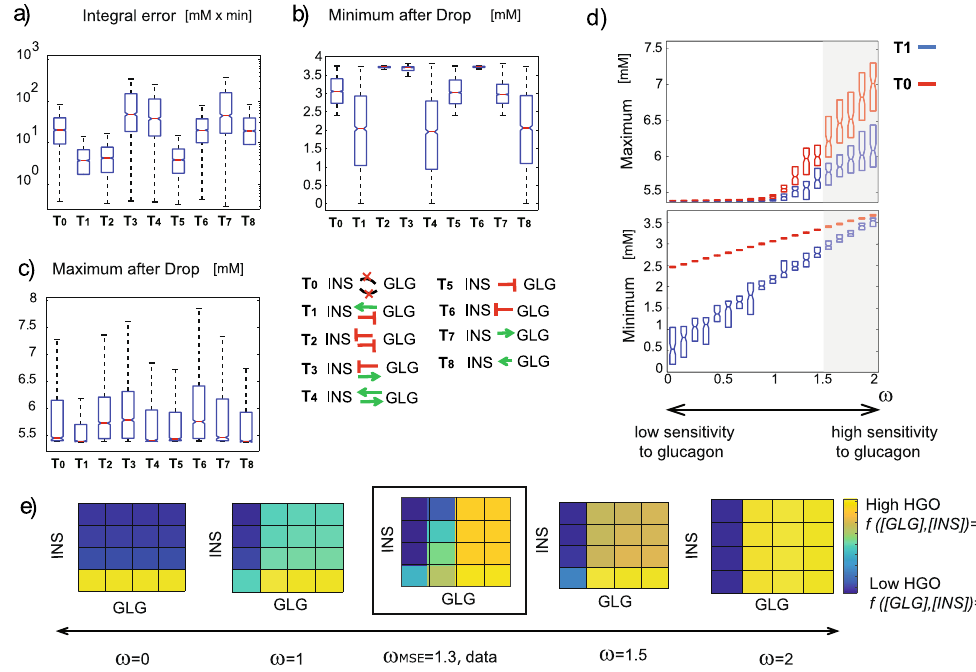
Figure 3. Global analysis reveals features of all circuit topologies. ( a ) Boxplots represent the integral positive error ( a ) minimum level after drop ( b ) and maximum overshoot after drop ( c ) of all circuit topologies. For each index, Kruskal-Wallis analysis reports pvalue < 0.001. ( d ) Undershoot of circuit T 1 can be minimized by increasing the liver sensitivity to glucagon. Grey shaded area represents the range of ω for which minimum is higher than 3 mM . ( e ) Hepatic glucose output as a function of glucagon and insulin is shown depending on the value of the liver sensitivity to glucagon (parameter ω ). Simulations have been performed considering Equation (5) as input function with parameters reported in Table 1. Plot in the black rectangle represents the data obtained from 37 . GLG ∈ [0, 5000] pM and INS ∈ [0, 10000] pM . GLG and INS axis are shown in logarithmic